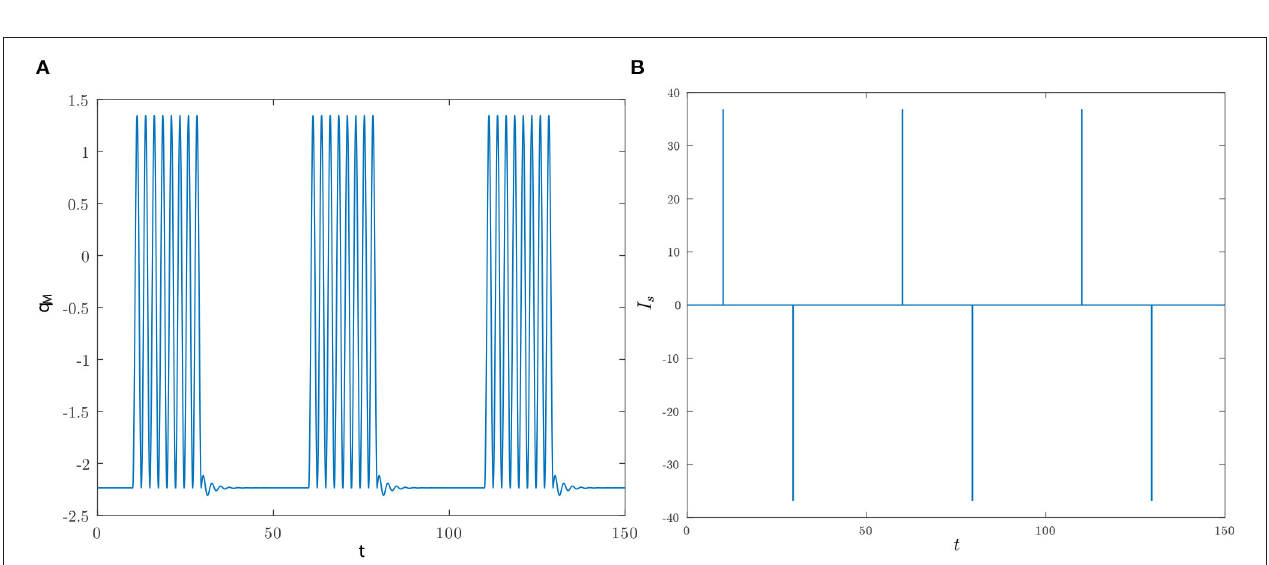
FIGURE 11 | The set pulse is applied at t i and width 1 0.0487. The initial conditions are Q (0) = state space generated by ( Q ( t ), q M ( t ), i L ( t )) (blu) and ( Q ( t ), q 0 M ( t ), i 0 L ( t )) (red).